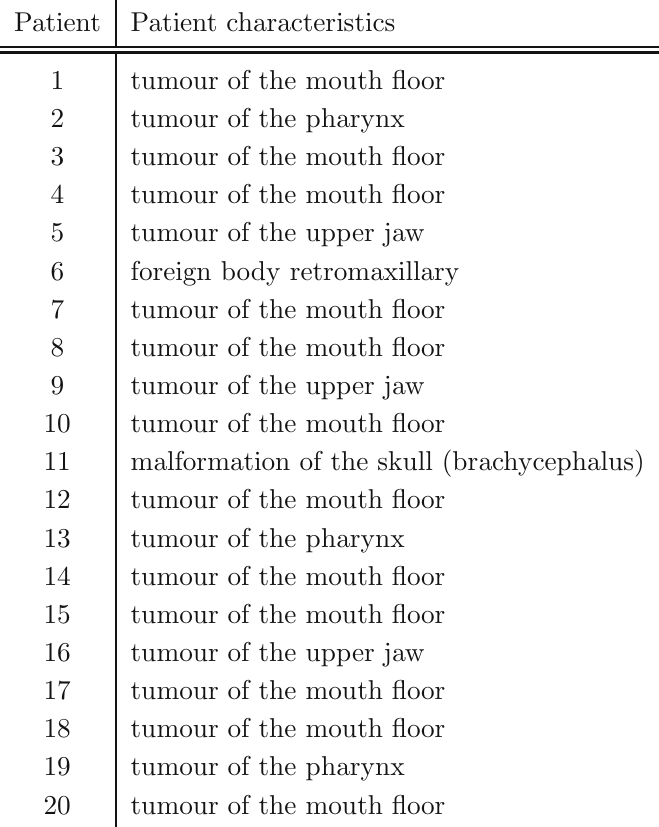
Table 1 Detailed patient